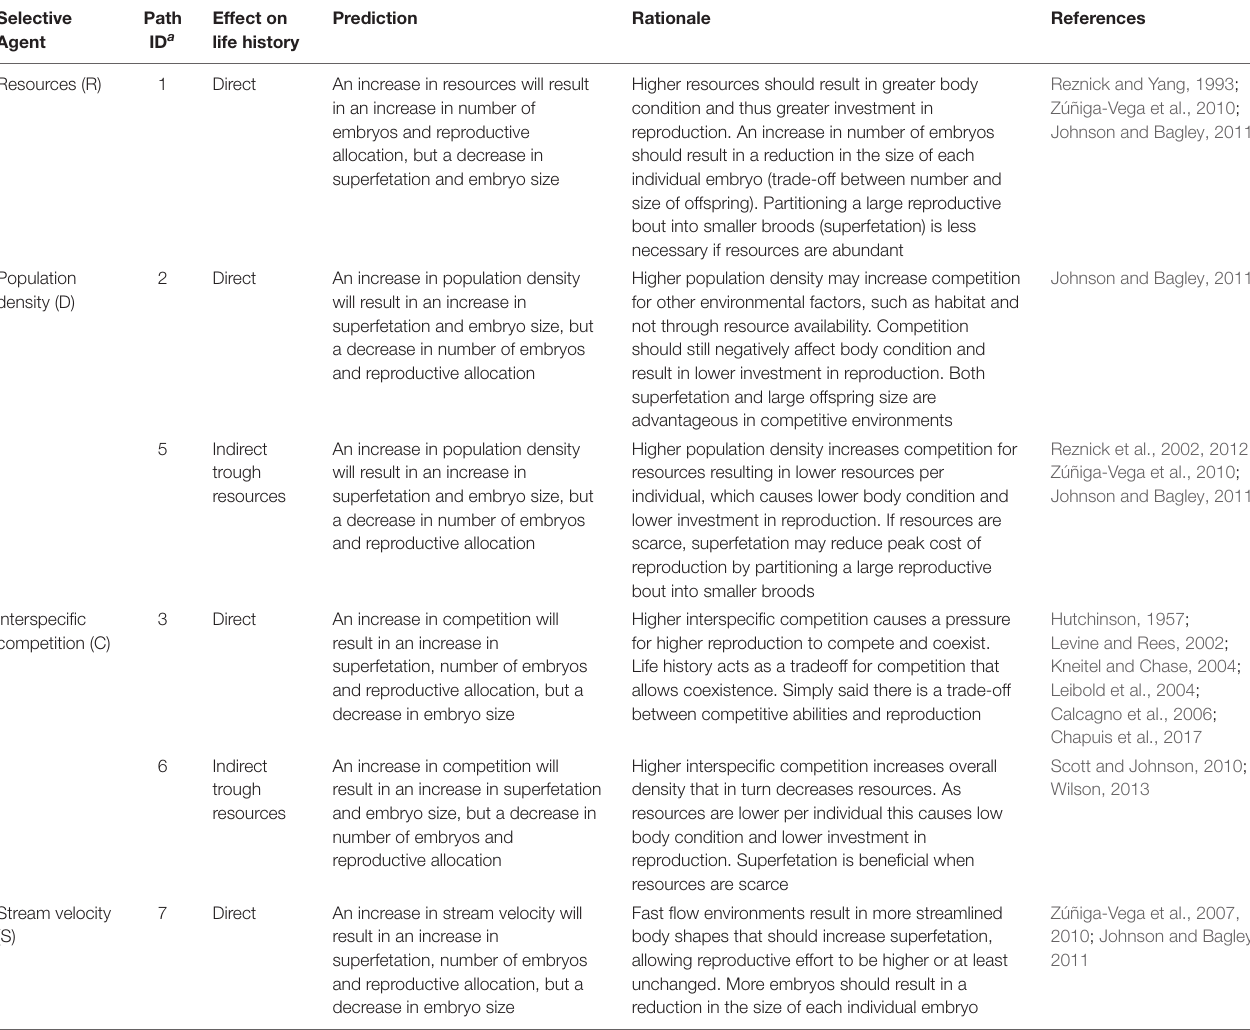
TABLE 1 | Potential effects of the four putative selective agents on the life history of P. prolifica